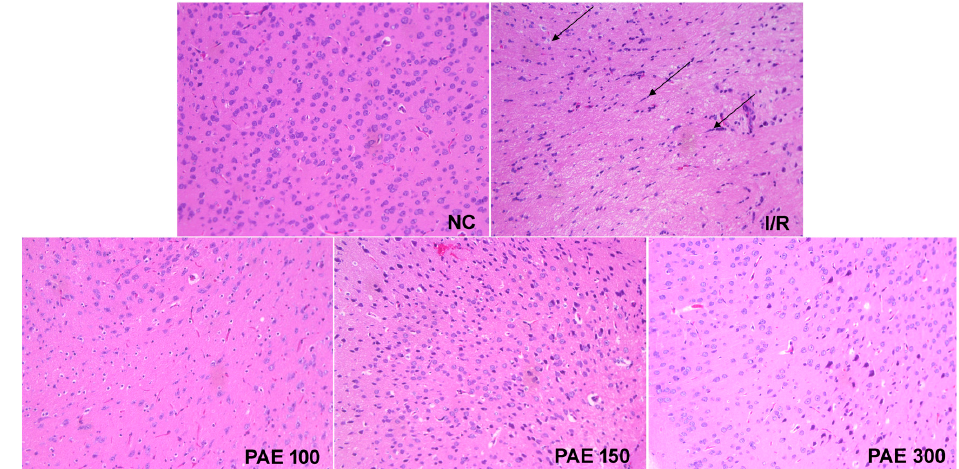
Figure 6. Effect of PAEs from Dongkui Myrica rubra on brain pathology in experimental mice (hematoxylin and eosin stain, ×200). The images are from the same region of the brain under different (hematoxylin and eosin stain, × 200). The images are from the same region of the brain under different experimental conditions. experimental